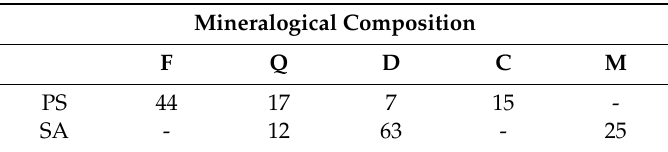
Table 1. Mineralogical compositions (wt. %) of studied raw materials. SA: Micaceous raw clay and